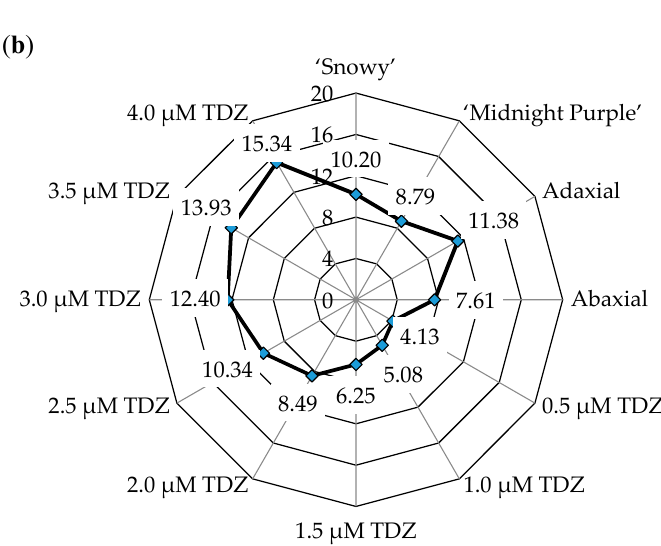
Figure 4. Effect of different factors on mean shoot formation frequency ( a ) and mean number of shoots per explant ( b ) in both cultivars.